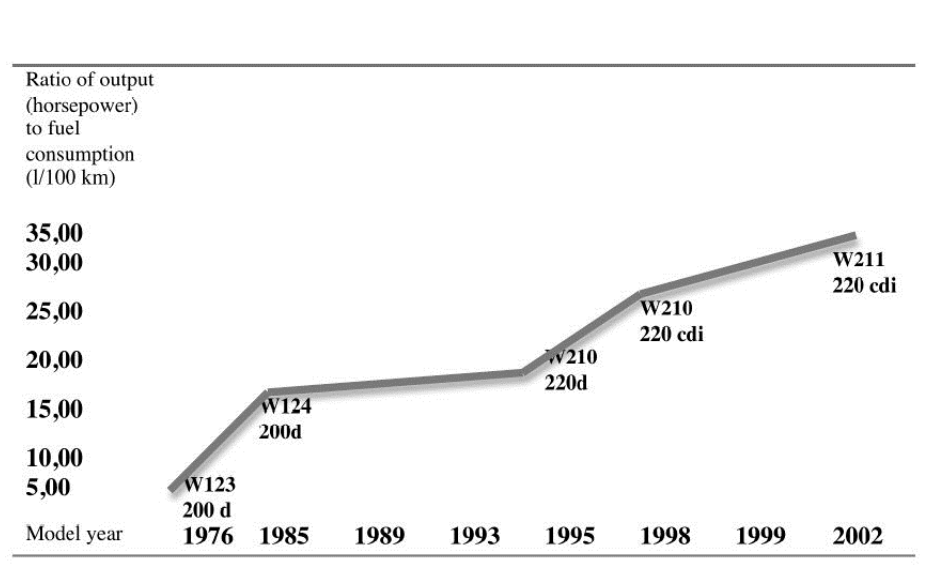
Figure 4 – The development of the horsepower output/fuel consumption ratio of Mercedes-Benz car diesels through model